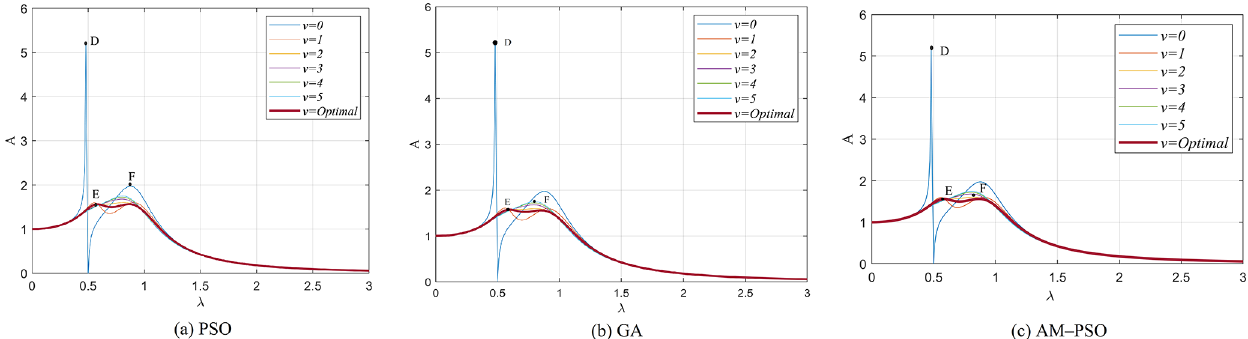
Figure 9. Influence of spring ratio ( v ) on the three-element DVA under different optimization algorithms.